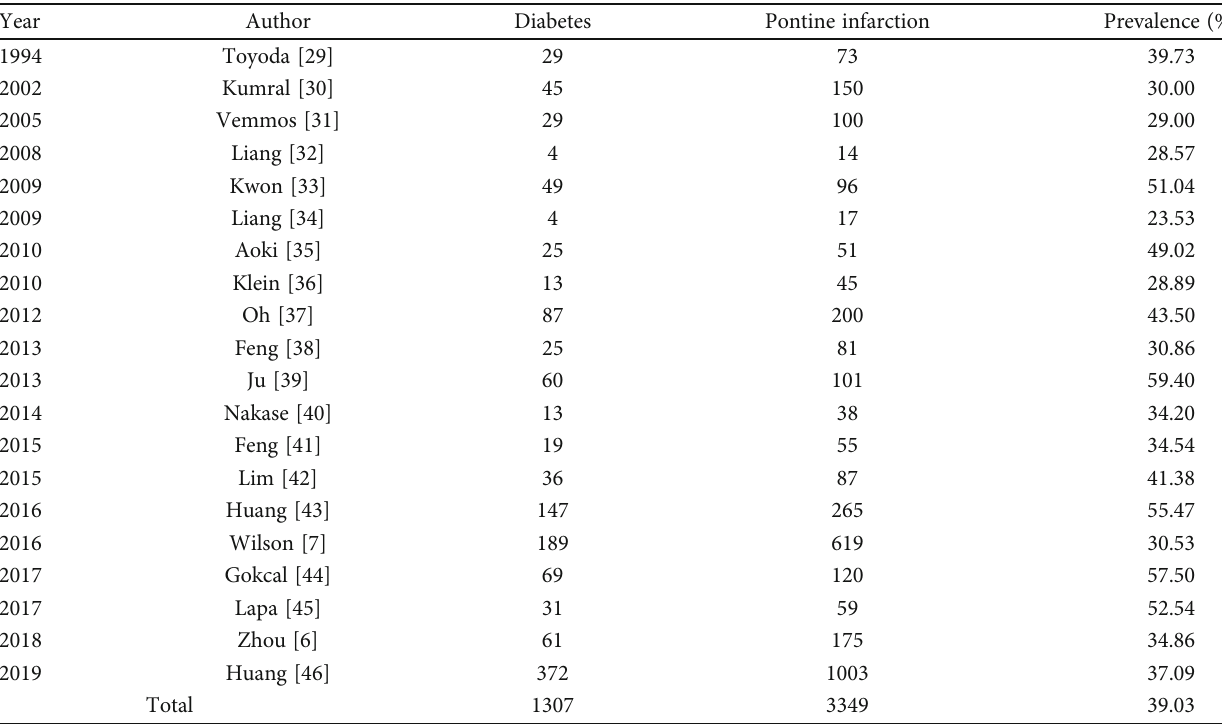
Table 5: Previous reports of diabetes in pontine